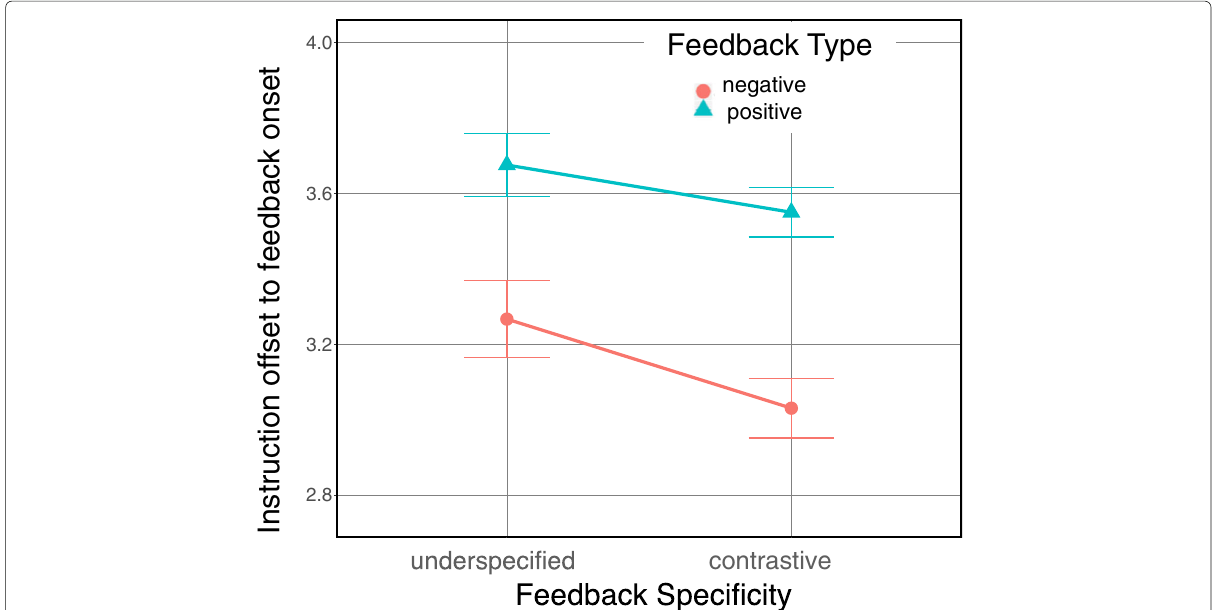
Fig. 5 Time interval from the instruction offset to the onsets of the first negative (triggered by a competitor inspection) and first positive (triggered by a target inspection) feedback instances for the ambiguous instructions in Experiment 1 (log transformed with 95% confidence interval error